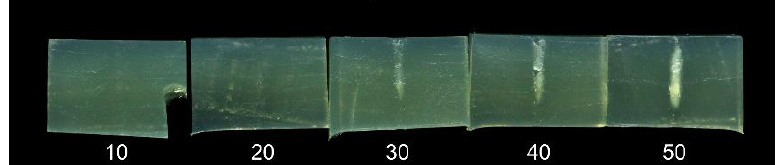
Figure 6. Slices of HIFU phantoms, treated with a 1 MHz transducer at a 55 mm distance for 10, 20, 30, 40, and 50 s (left to right). The phantom temperature was approx. 4 °C before treatment.